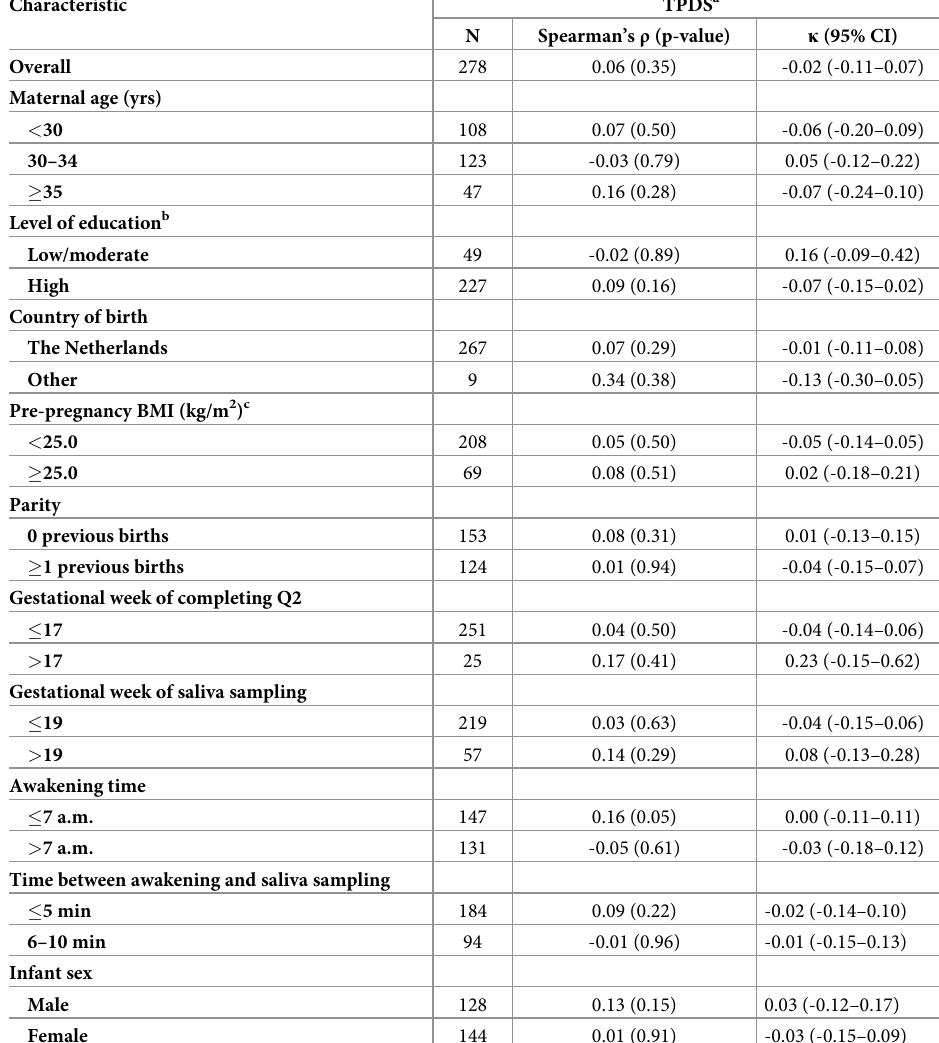
Table 3. Spearman correlation coefficients and Cohen’s Kappas of awakening cortisol levels and Tilburg Preg- nancy Distress Scale (TPDS) scores in a subpopulation.